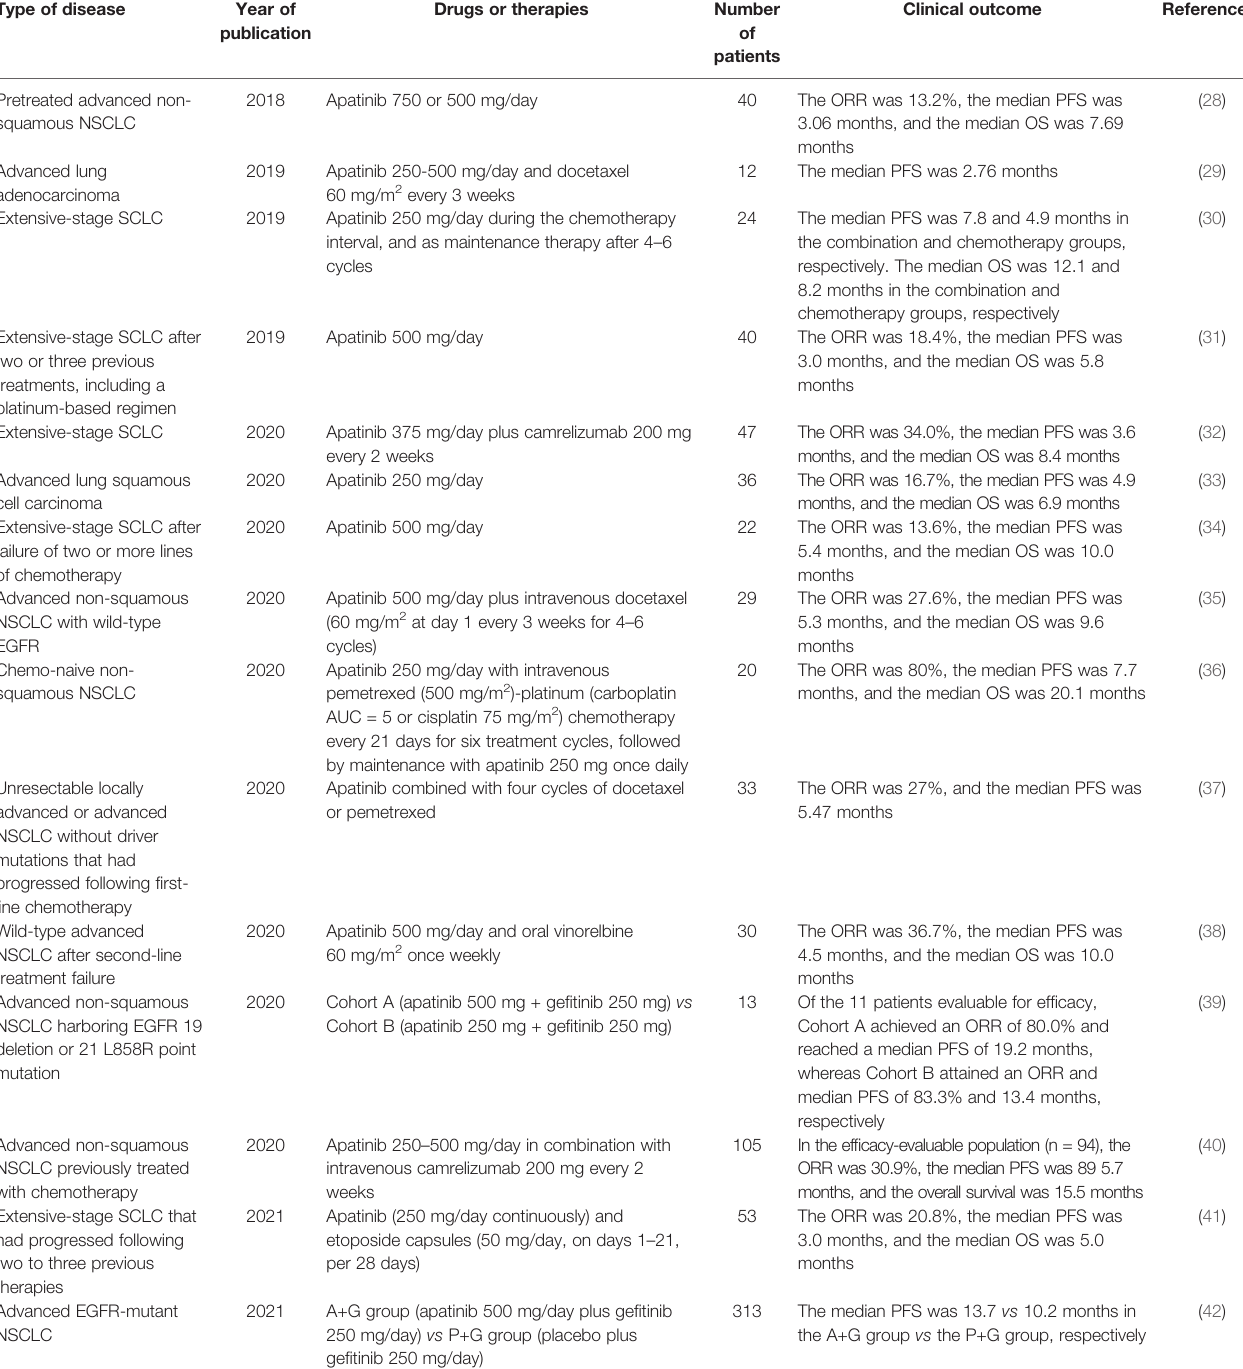
TABLE 3 | Clinical trials on apatinib for lung cancer treatment included in this